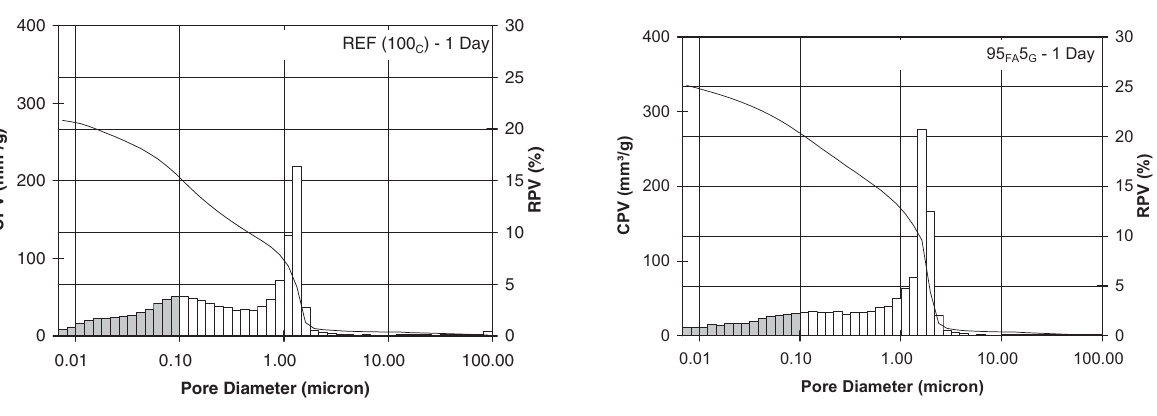
Fig. 2. Pore size distribution of the reference paste P1